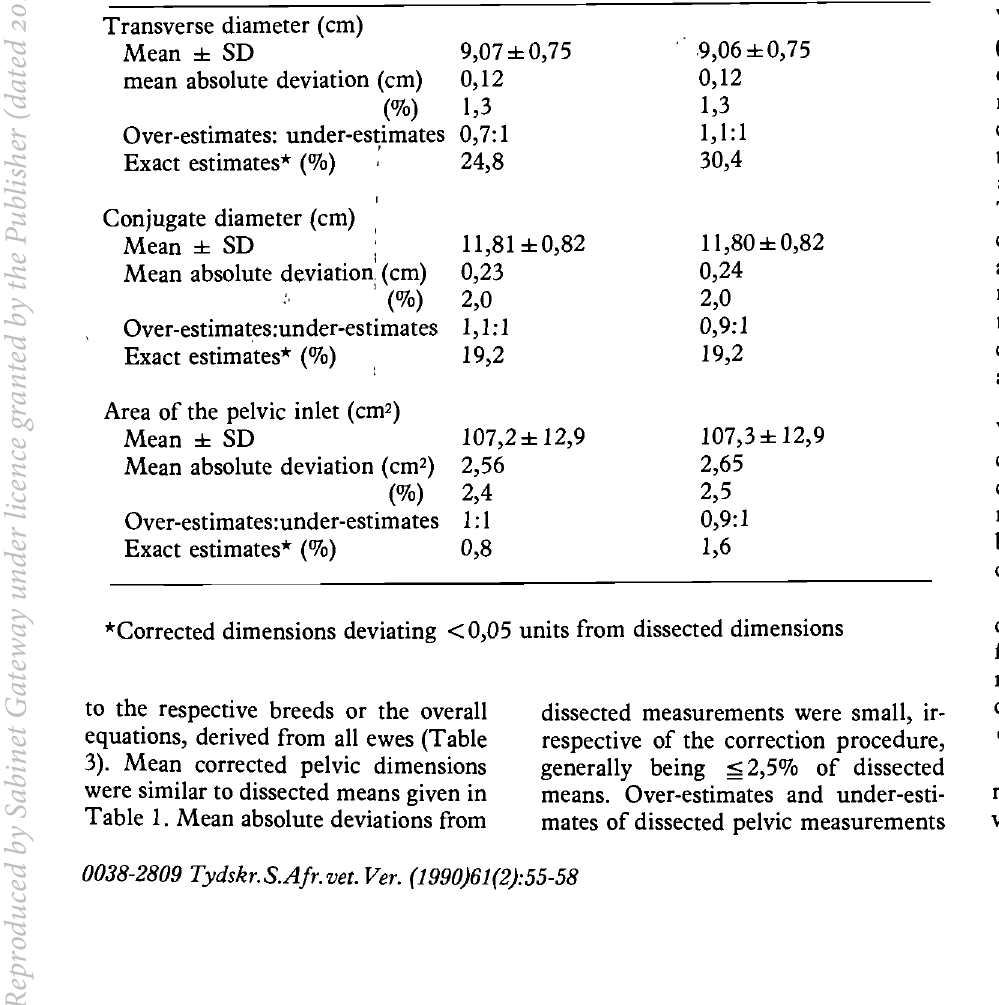
Table 3: Mean (± SD) corrected pelvic dimensions, mean absolute devia tions from dissected measurements and the proportion over estimates: under-estimates of dissected measurements, using breed-specific or overall regressions in the correction procedure for all 125 ewes